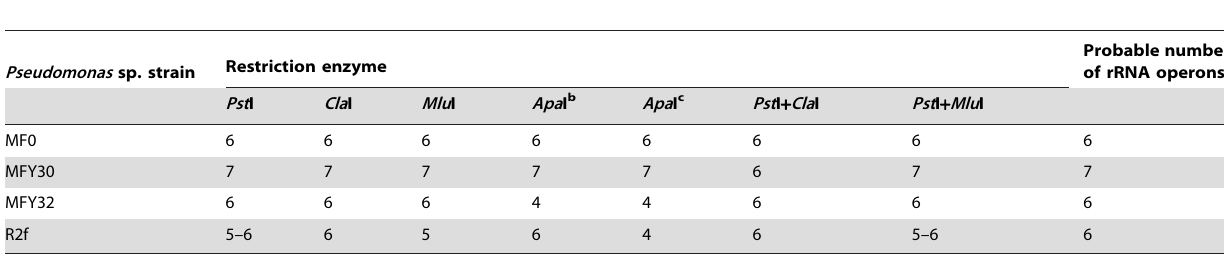
Table 1. Number of chromosomal restriction fragments that hybridize with rRNA probes by Southern analysis a .